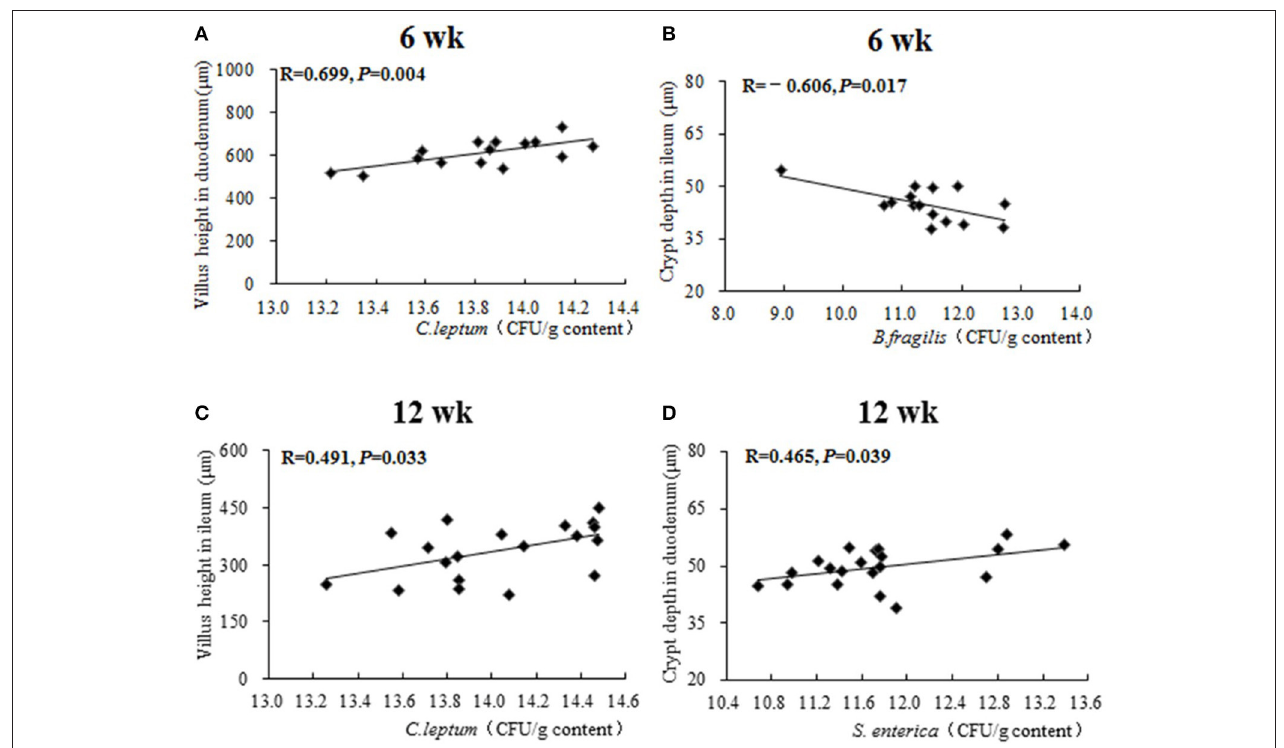
FIGURE 5 | The Pearson correlation analysis between caecal microbiota and intestinal morphology. The plots represent the samples in all treatments from 0 to 16 weeks, the transverse line represents the linear relationship between caecal microbiota and intestinal morphology. R- value: Pearson correlation coefficient, R > 0 represents positive correlation: R < 0 represents negative correlation. P- value: significance was declared at P < 0.05. (A) Correlational relationship between population of caecal C. leptum and villus height in duodenum at week 6; (B) Correlational relationship between population of caecal B. fragilis and crypt depth in ileum at week 6; (C) Correlational relationship between population of caecal C. leptum and villus height in ileum at week 12; (D) Correlational relationship between population of caecal S. enterica and crypt depth in duodenum at week